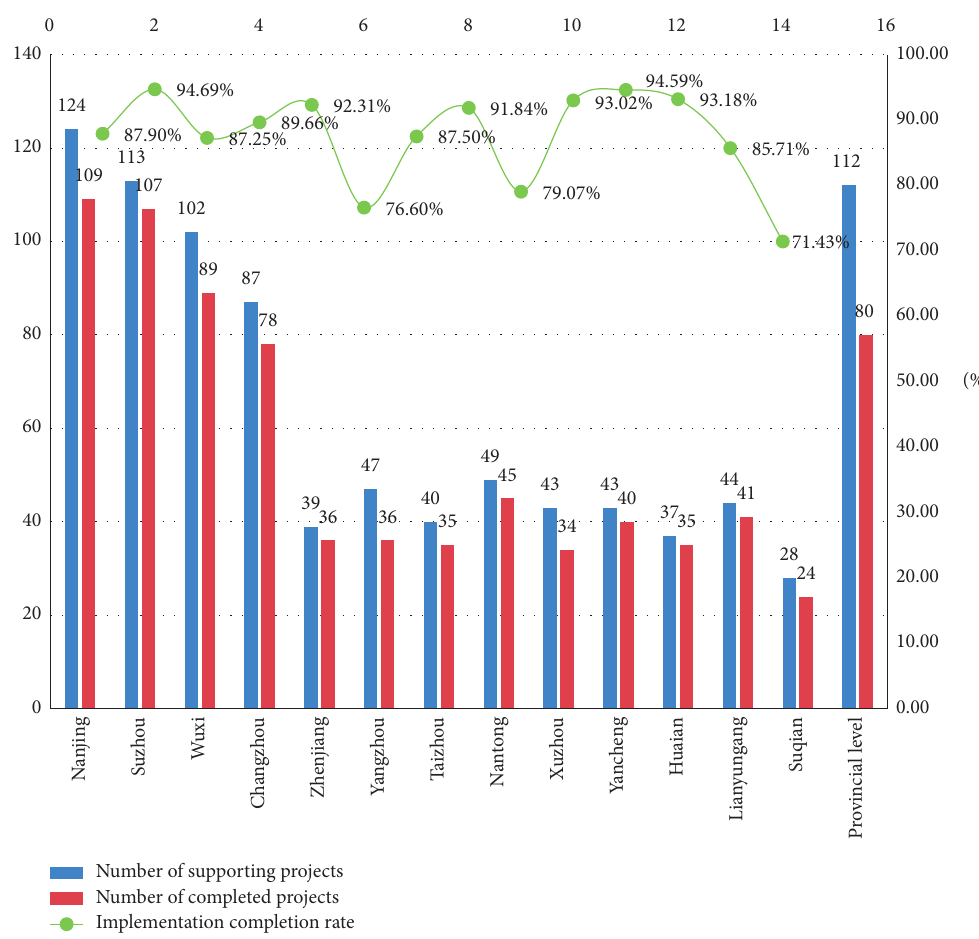
Figure 6: Implementation completion rate of supporting projects in various regions from 2011 to